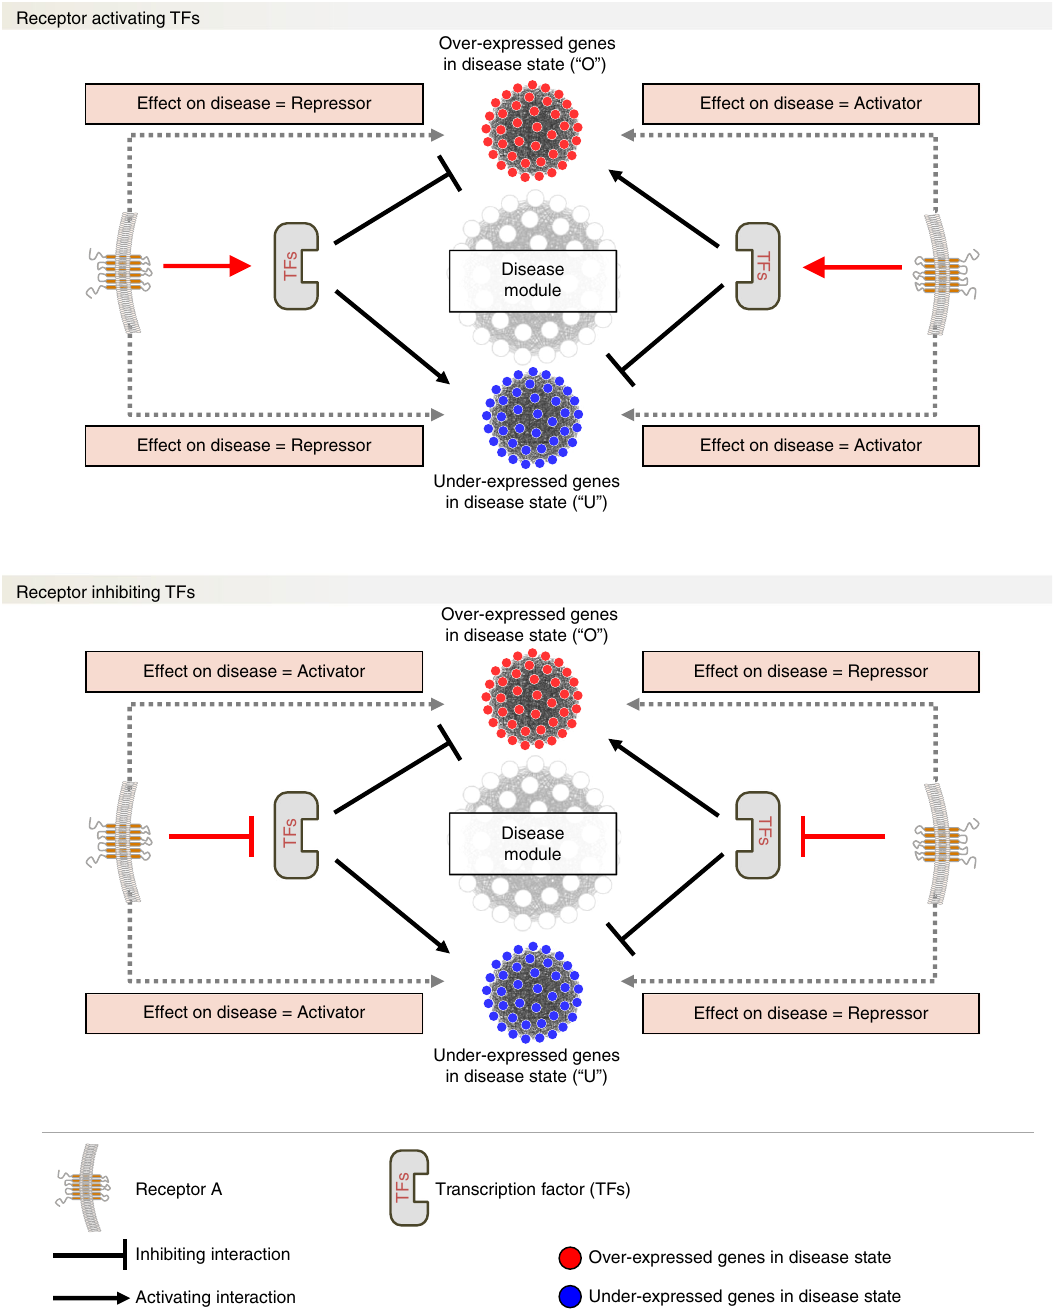
Fig. 3 Causal reasoning framework. A knowledge-based “ interactome ” (or "regulome") connecting membrane receptors to module gene expression was constructed based on experimentally validated connections between membrane receptors and transcription factors (TFs) in linear pathways, and between TFs and their target genes (genome-wide). This “ regulome ” is then integrated with information about whether the genes in a candidate module are over- expressed ( “ O ” ) or under-expressed ( “ U ” ) in the disease state, allowing receptors to be classi fi ed as either disease “ Activators ” or “ Repressors, ” which in turn permits the therapeutic directionality of receptor blockade or activation to be inferred. In the upper part of the fi gure, we show the positive activation of the TFs by the receptor “ Receptor A, ” whereas in the lower part of the fi gure we show the opposite scenario of inactivation of the TFs by Receptor A. An illustrative example of the framework is shown in Supplementary Figure